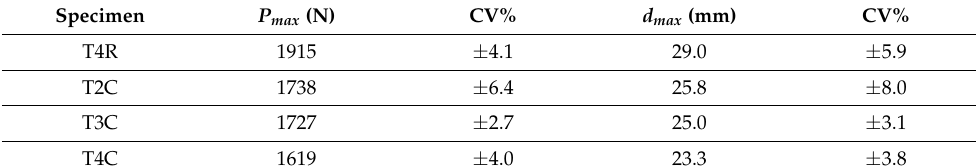
Figure 7. ( a ) Uncoated rebars, force vs. deflection. ( b ) Coated rebars, force vs. deflection .